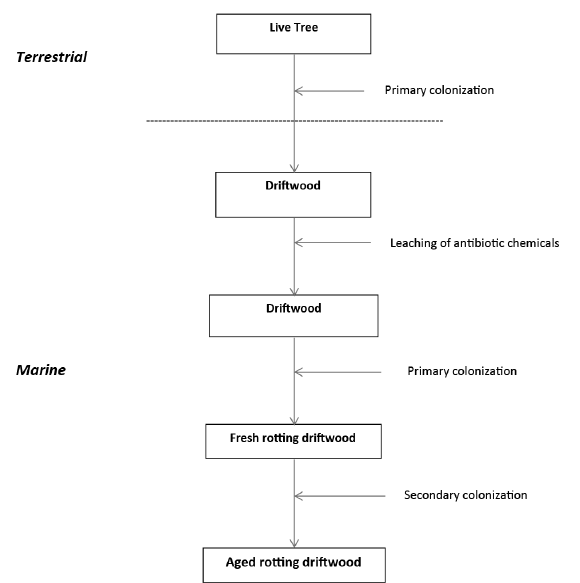
Figure 1. Driftwood decay succession in the marine/estuarine environment. Primary colonizers include cellulolytic fungi and bacteria, gribbles and chelurid amphipods. Secondary colonizers include talitrids, isopods, chilopods, insect larvae, ants,